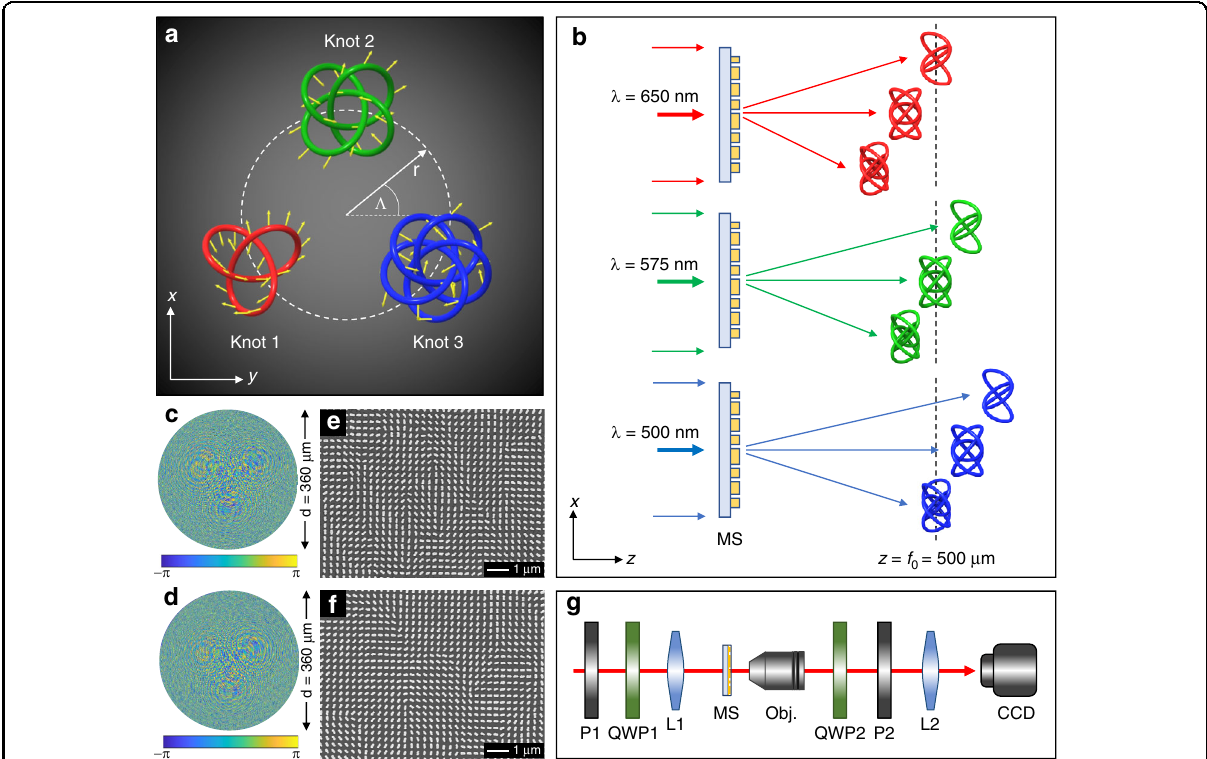
Fig. 2 Polarization knots arrangement, color-selective mechanism, SEM images of fabricated samples, and schematic of the experimental setup. a The arrangement of the 3D polarization knots. The polarization direction of any given point is denoted with yellow arrows. b Color-selective mechanism. The locations of three different 3D knots are given upon the illumination of the incident light at λ = 650 nm (top), λ = 575 nm (middle), and λ = 500 nm (bottom), respectively. The observation region is de fi ned by the two planes: z = 485 μ m and z = 515 μ m. The plane z = 500 μ m is the middle plane of the observation region. Only one 3D polarization knot is obtained for a single incident wavelength; thus, the color-selective functionality is realized. c and d are the desired phase pro fi les for the two metadevices that can respectively generate multiple polarization knots and color-selective polarization knots in the same observation region. The corresponding scanning electron microscope (SEM) images of the fabricated metasurface devices are shown in ( e ) and ( f ), respectively. g Schematic of the experimental setup for characterizing the developed metadevices. P1 and P2: polarizers, QWP1 and QWP2: quarter wave plates, L1: convex lens ( f = 15 cm), MS: metasurface device, Obj.: ×20 objective lens, L2: convex lens ( f = 10 cm), CCD: charge-coupled